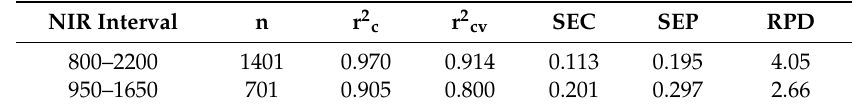
Figure 4. Validation of the 800–2200 PLS model for FA determination. Table 1. Statistics of the PLS models obtained for the two assayed near-infrared spectroscopy (NIRS) intervals.